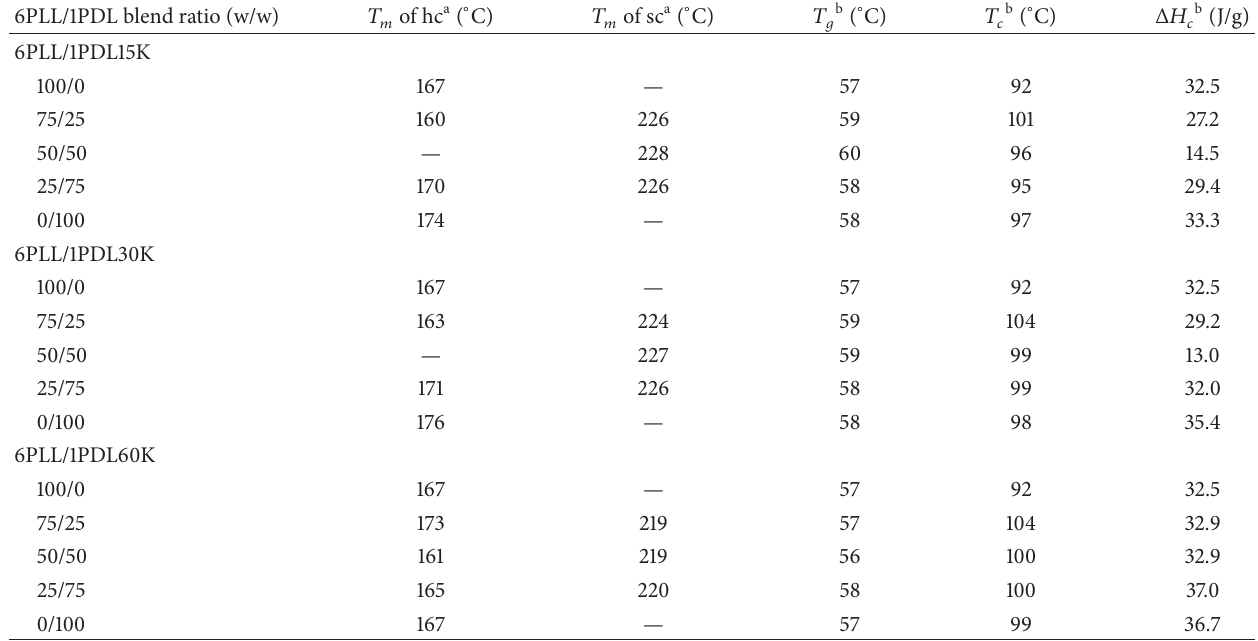
Table 1: Thermal transition properties of 6PLL, 1PDL, and 6PLL/1PDL